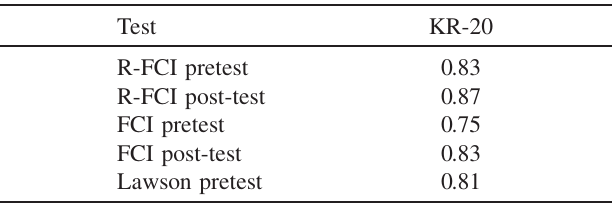
TABLE III. KR-20 values for different tests ( n ¼ 131 ).